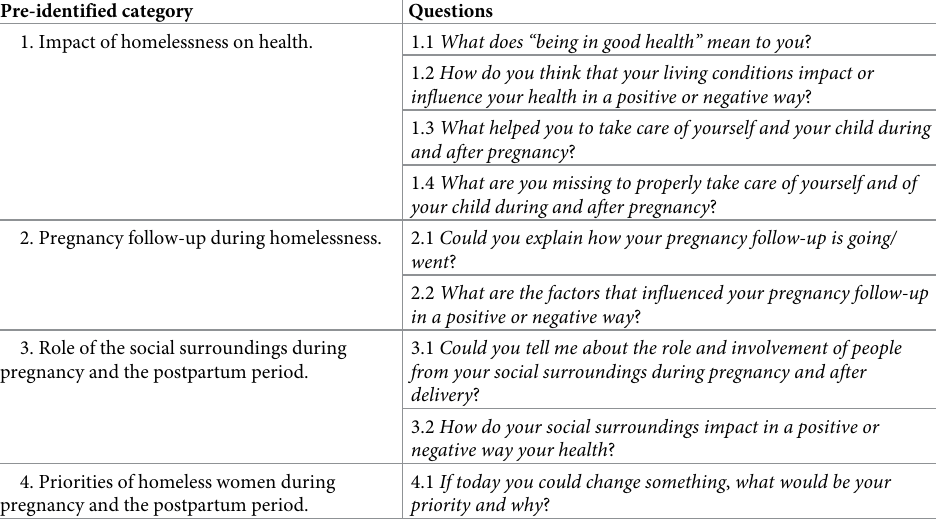
Table 1. Interview guide used for homeless pregnant women or homeless women in the postpartum